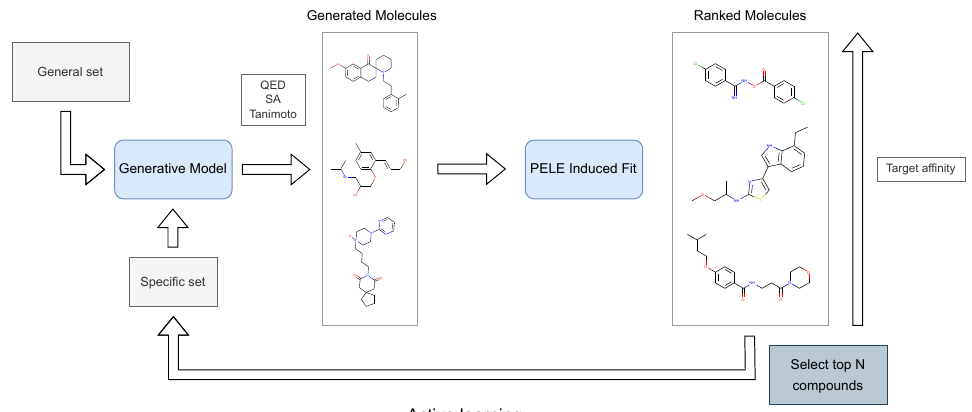
Figure 2. Active learning schema depicting the process used for iterative generation and enhancement of potential